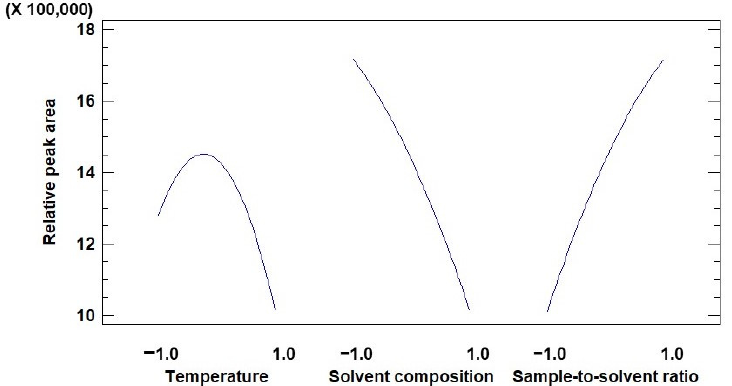
Figure 5. Plots representing the main effects from temperature, solvent composition and sample ‐ solvent ratio.